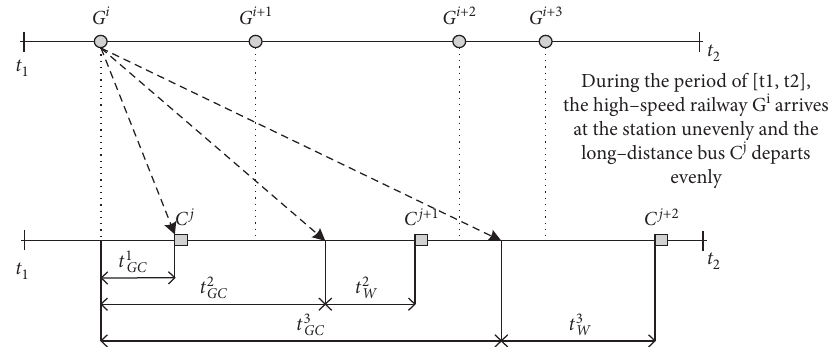
Figure 1: Analysis of travel time of transfer